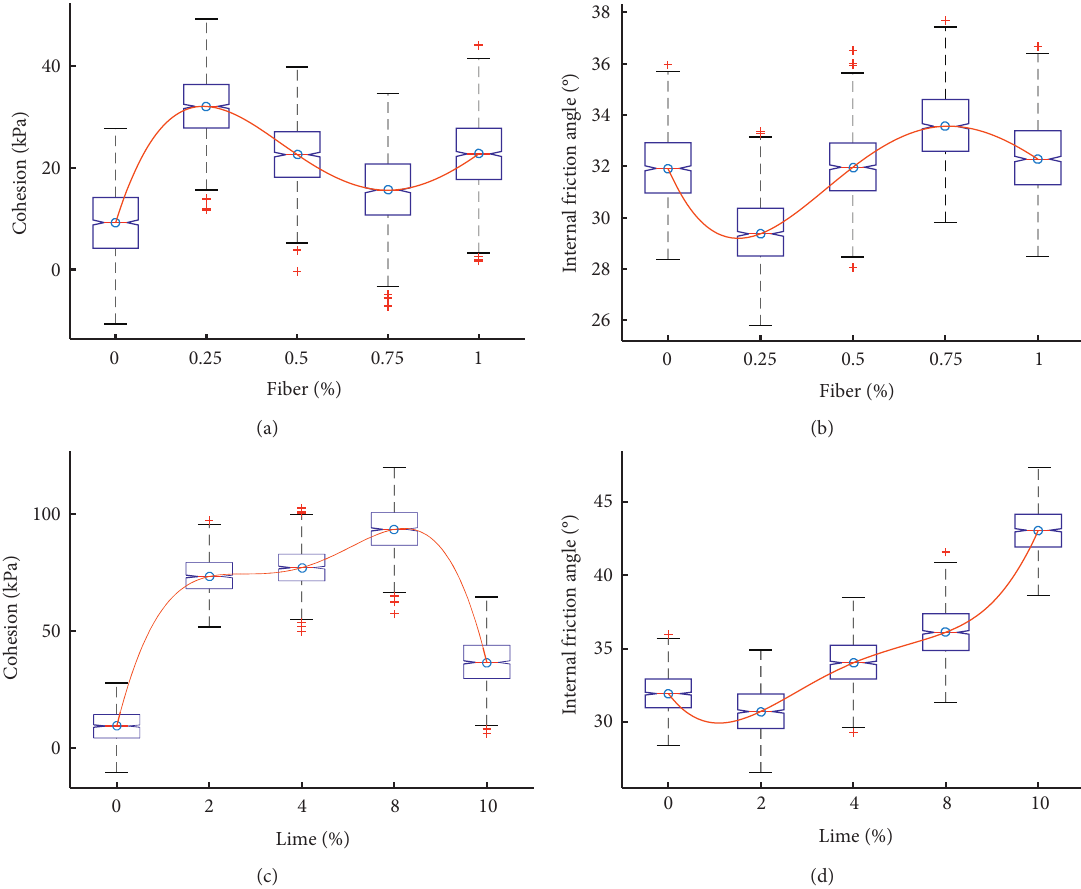
Figure 7: The change trend of the confidence interval of c and φ of the modified iron tailings with the 0 freeze and thaw cycle: (a) the confidence interval of c varies with the fiber content, (b) the confidence interval of φ varies with the fiber content, (c) the confidence interval of c varies with the lime content, and (d) the confidence interval of φ varies with the lime